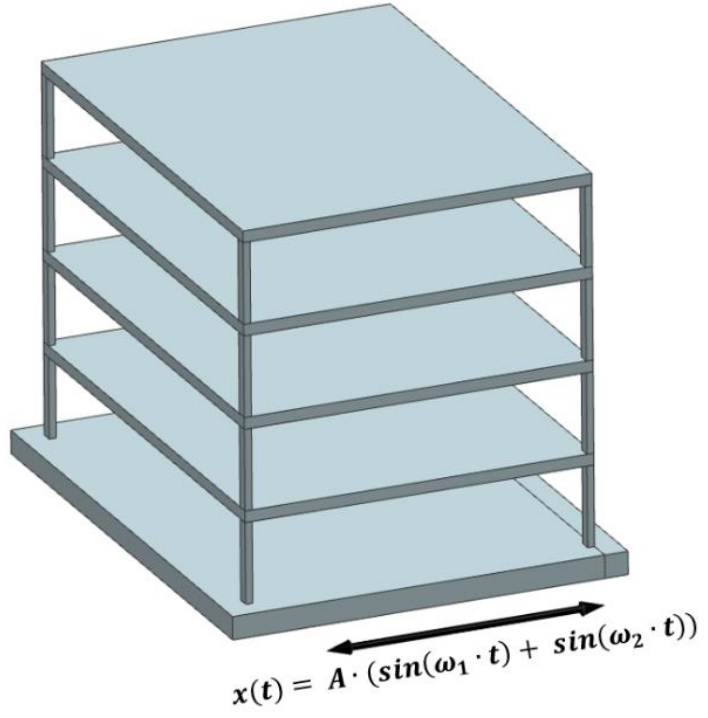
Figure 8. Applied excitation in the first analyzed case.